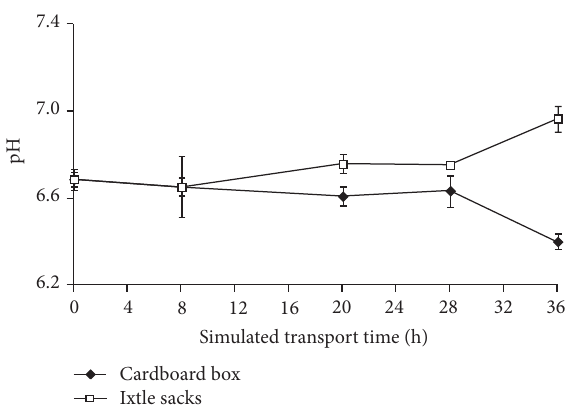
Figure 2: Glycogen concentration (mg/g dry weight) of Crassostrea gigas oyster during in vivo transport in cardboard box and ixtle sacks. Data shown are mean of 𝑛 = 4 . Bars represent deviation standard.